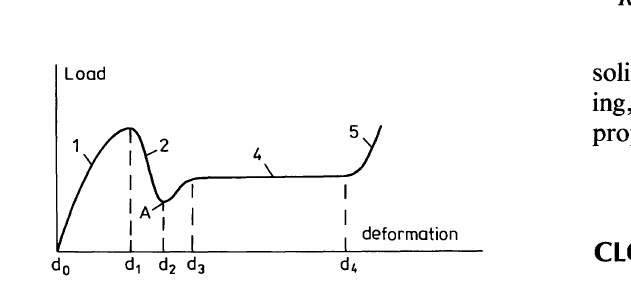
FIGURE 8 Global load-deformation response: 1, uniform deformation; 2, localization; A, arrest; 4, propagation, 5, uniform